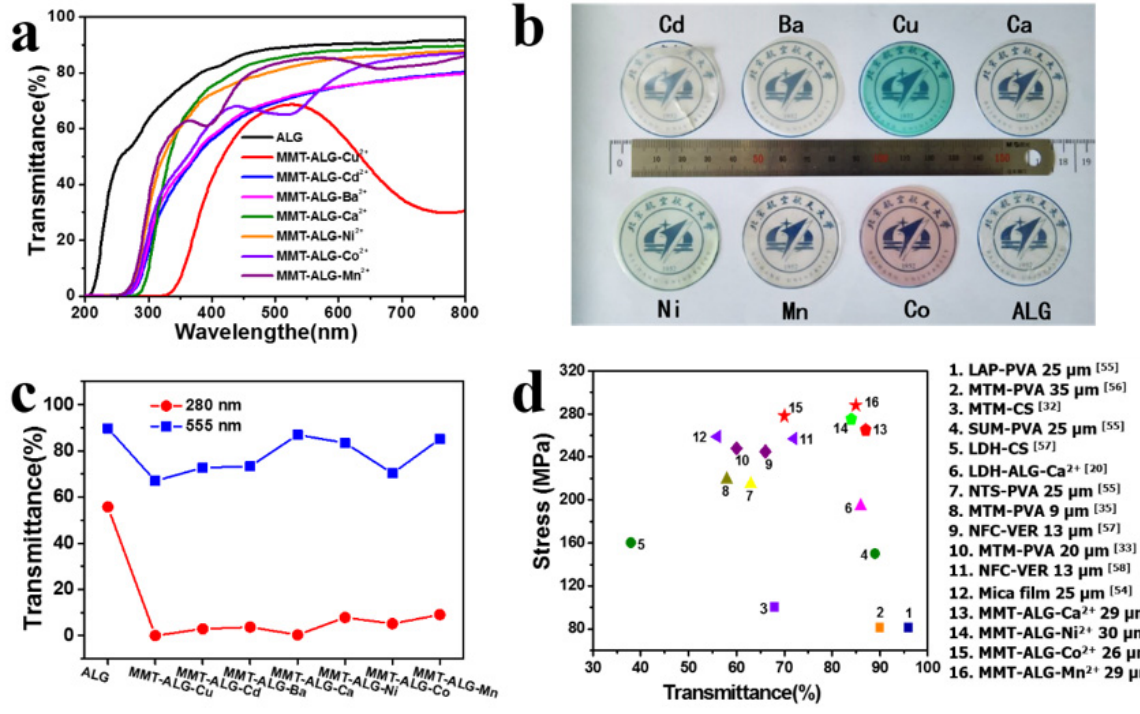
Figure 6. ( a ) UV-Vis transmittances of ALG, MMT-ALG-X 2+ artificial nacre. ( b ) Digital photo of ALG and MMT-ALG-X 2+ artificial nacre. ( c ) Transmittances of MMT-ALG-X 2+ artificial nacre at 555 nm and 280 nm with; ( d ) The strength and transmittance at 555 nm of MMT-ALG-X 2+ film were compared with those of other nanoclay-based nacre-like films. [20,32,33,35,54–58].